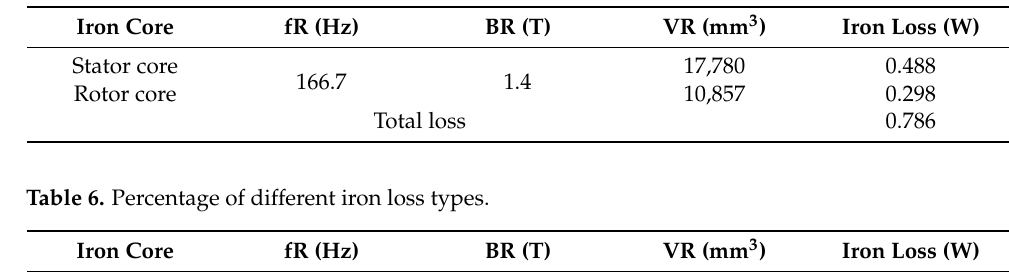
Table 4. Direct fitting results of parameters for silicon steel sheets. Table 5. Main parameters and loss calculation results of the AMB.